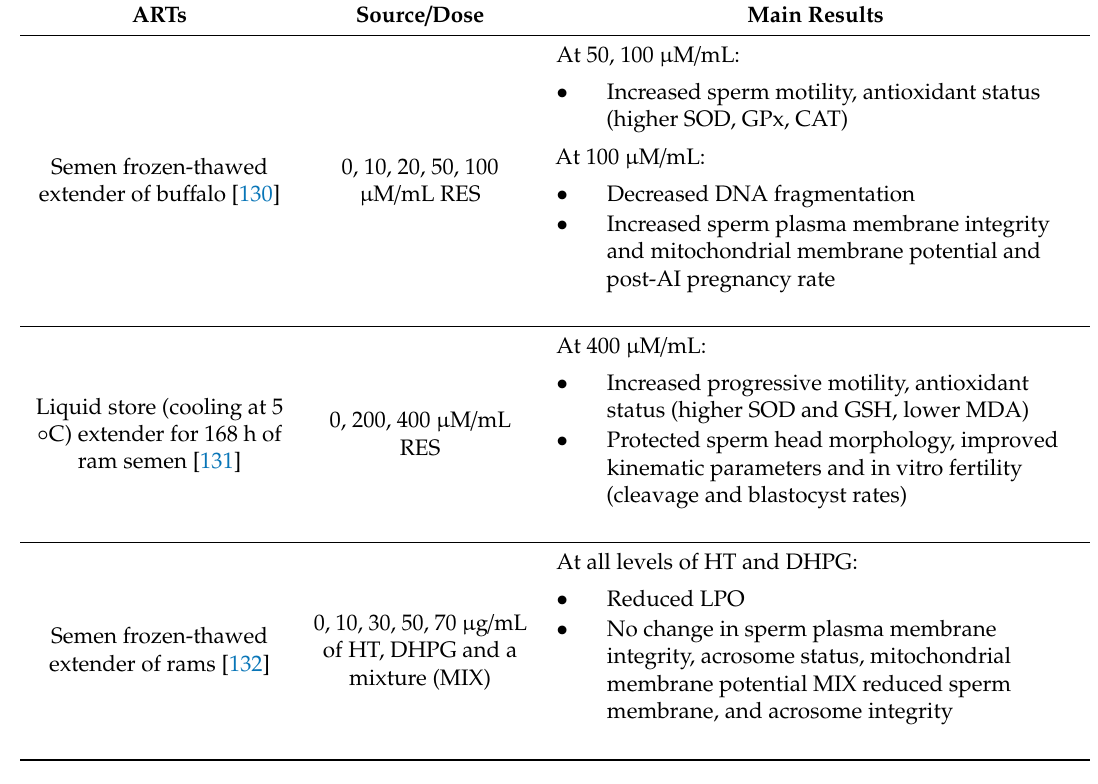
Table 4. Summary of recent in vitro studies on the e ff ects of polyphenols on outputs of some assisted reproductive techniques (ARTs) in male farm